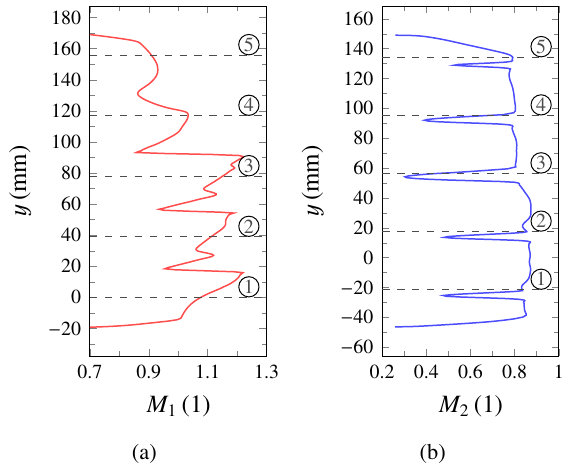
Fig. 9 . Mach number in the plane in the normal distance of 15mm upstream the cascade (a) and in the plane 15mm downstream the cascade